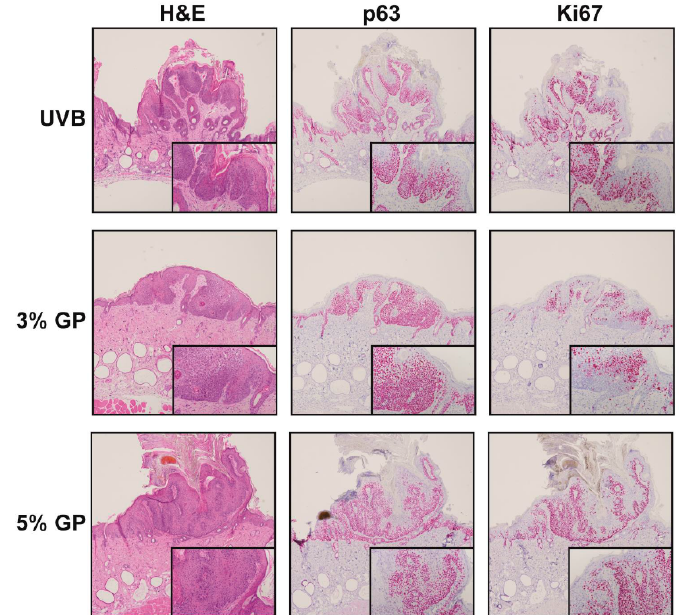
Figure 4. Dietary GP consumption does not affect premalignant growth patterns following long-term UVB exposure in SKH-1 hairless mice. Histological analysis of exophytic papillomas with a G2 atypia score from the UVB-treated groups. Staining includes hematoxylin and eosin (H&E), epithelial marker p63, and proliferative marker Ki67. Images were obtained at 4× magnification and inset at 20× magnification.